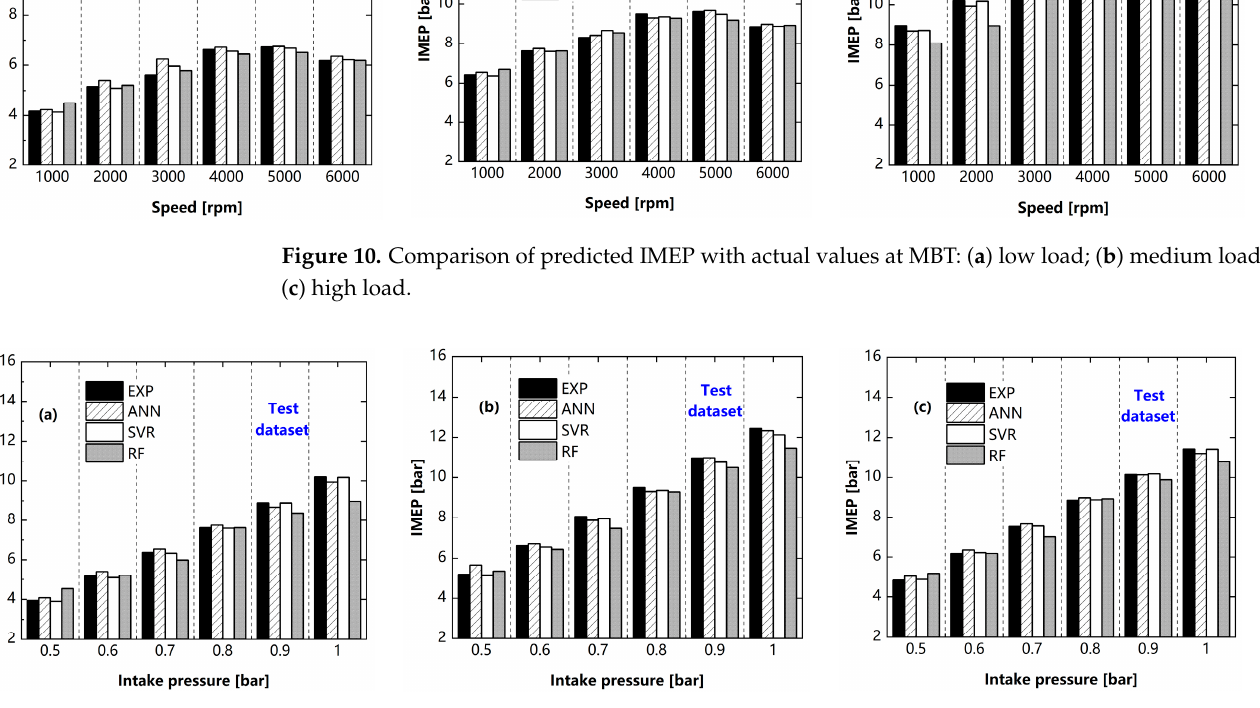
Figure 11. Comparison of predicted IMEP with actual values at MBT: ( a ) low speed; ( b ) medium speed; ( c ) high speed.